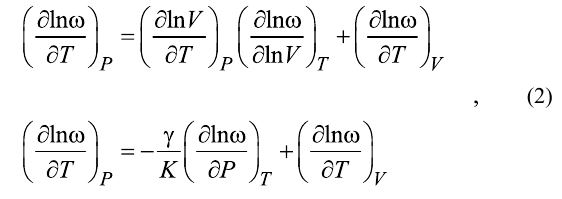
was affected by temperature. This change in Raman modes is mainly due to the contribution from the thermal anharmonicity.